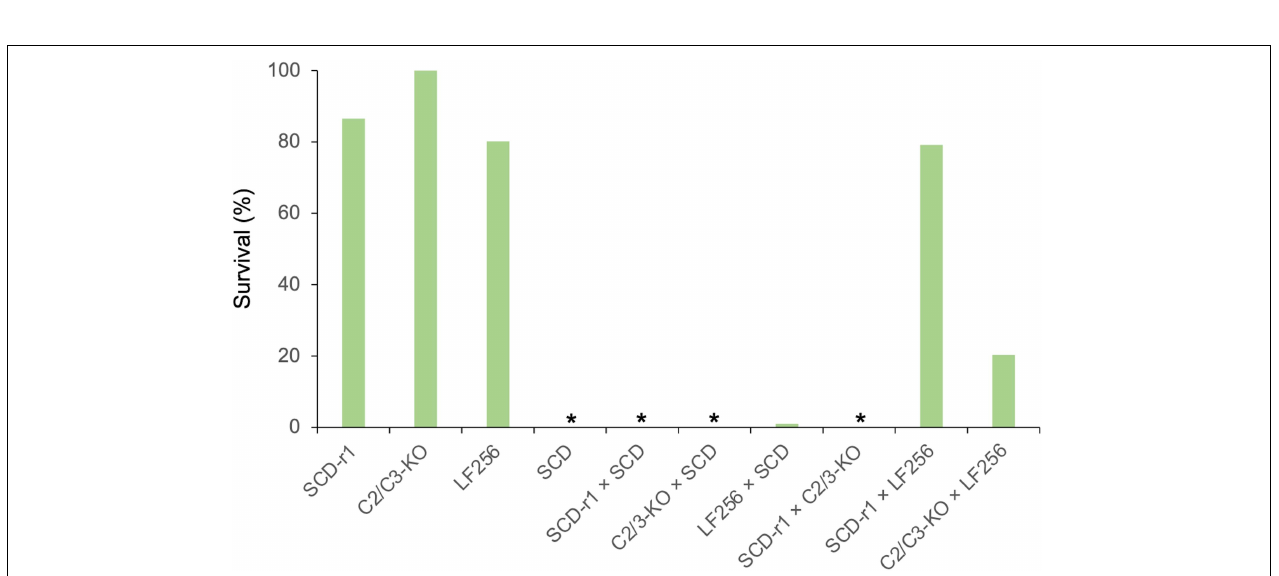
FIGURE 3 | Survival at the diagnostic concentration of Cry1Ac of H. armigera larvae from three resistant strains (SCD-r1, C2/C3-KO, and LF256), a susceptible strain (SCD), and the F 1 progeny from crosses between strains. Asterisks indicate 0% survival for SCD and the progeny from three crosses: SCD-r1 × SCD, C2/3-KO × SCD, and SCD-r1 × C2/3-KO. Survival for progeny from LF256 × SCD was 1.0%.